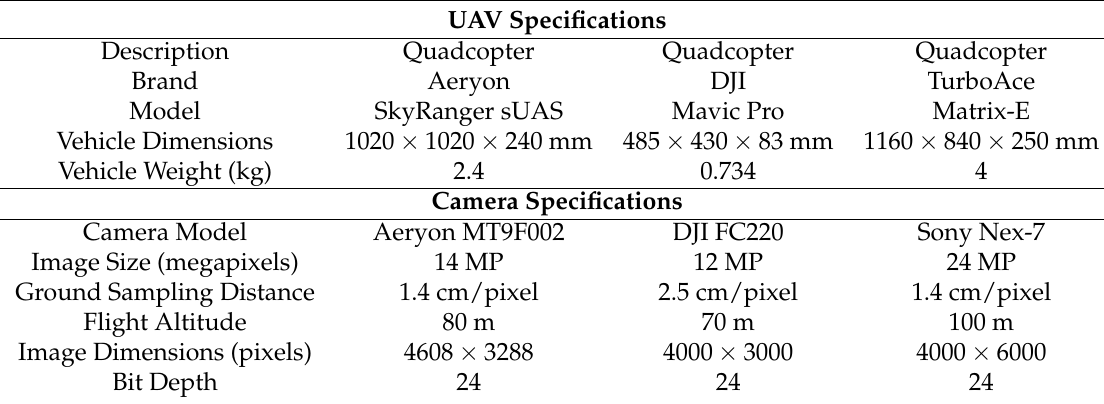
Table 1. Unmanned aerial vehicles (UAVs) and cameras